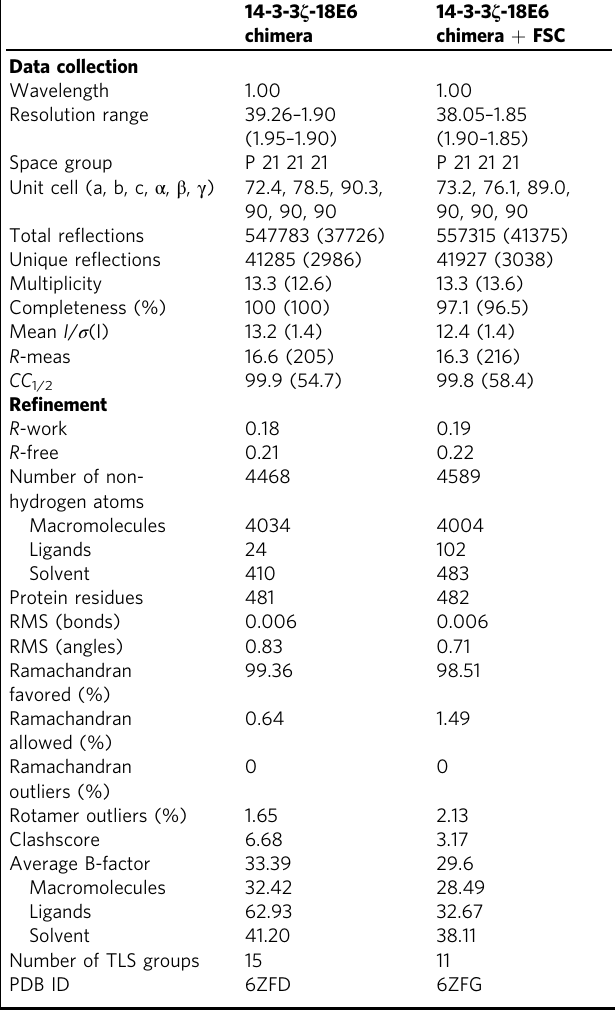
Table 1 Crystallographic